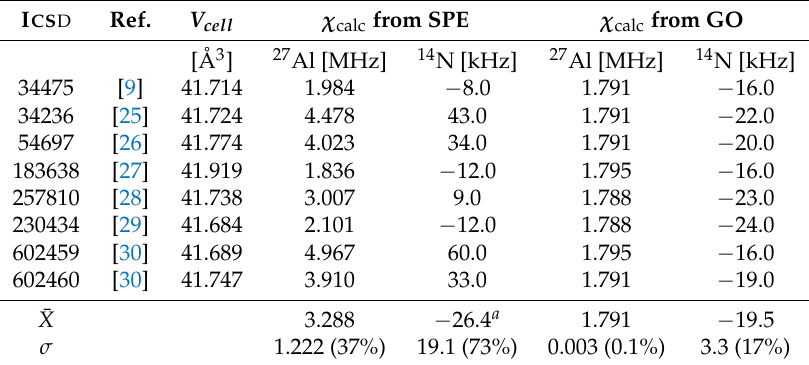
Table 3. Quadrupolar coupling constant χ calc for 27 Al and 14 N in aluminum nitride, as determined from DFT calculations with the C ASTEP code. Calculations were run using the atomic coordinates of the reported crystal structures directly (single-point energy—SPE), and after geometry optimization (GO) of the unit